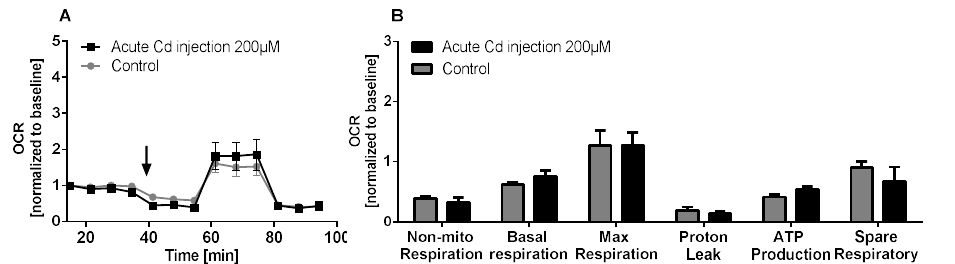
Figure 7. Energy phenotype assay (in vitro). ( A ) OCR vs ECAR of control and Cd-exposed coelomocytes. The term stressed refers to the state after Oligo/FCCP addition. ( B–C ) Metabolic ECAR and OCR potential of in vitro Cd exposed coelomocytes. *ANOVA on ranks and post-hoc Tukey test revealed significant differences at p ≤ 0.05.